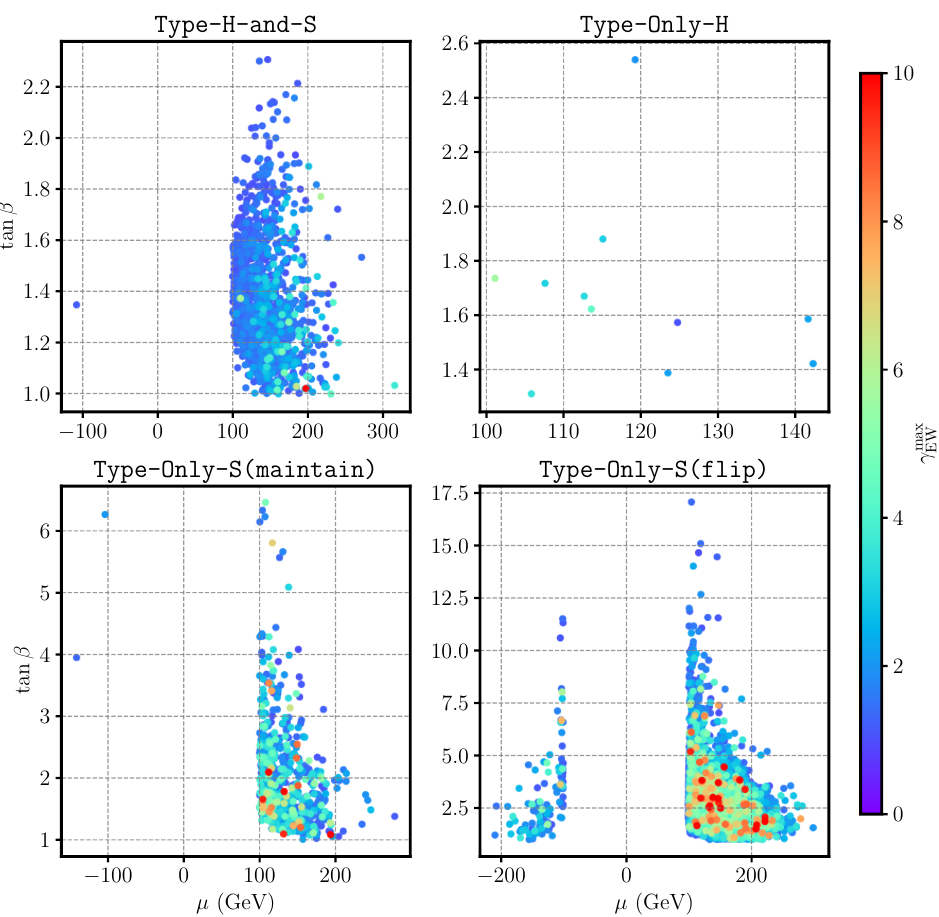
Figure 4 . The parameters ( (cid:22) e(cid:11) ; tan (cid:12) ) for samples for which the strongest FOPT ends in the SM vacuum. The points are colored by the (cid:13) EW of the strongest FOPT. the range m SUSY X t m SUSY and no particular value of m SUSY was preferred by (cid:0) (cid:20) (cid:20) our